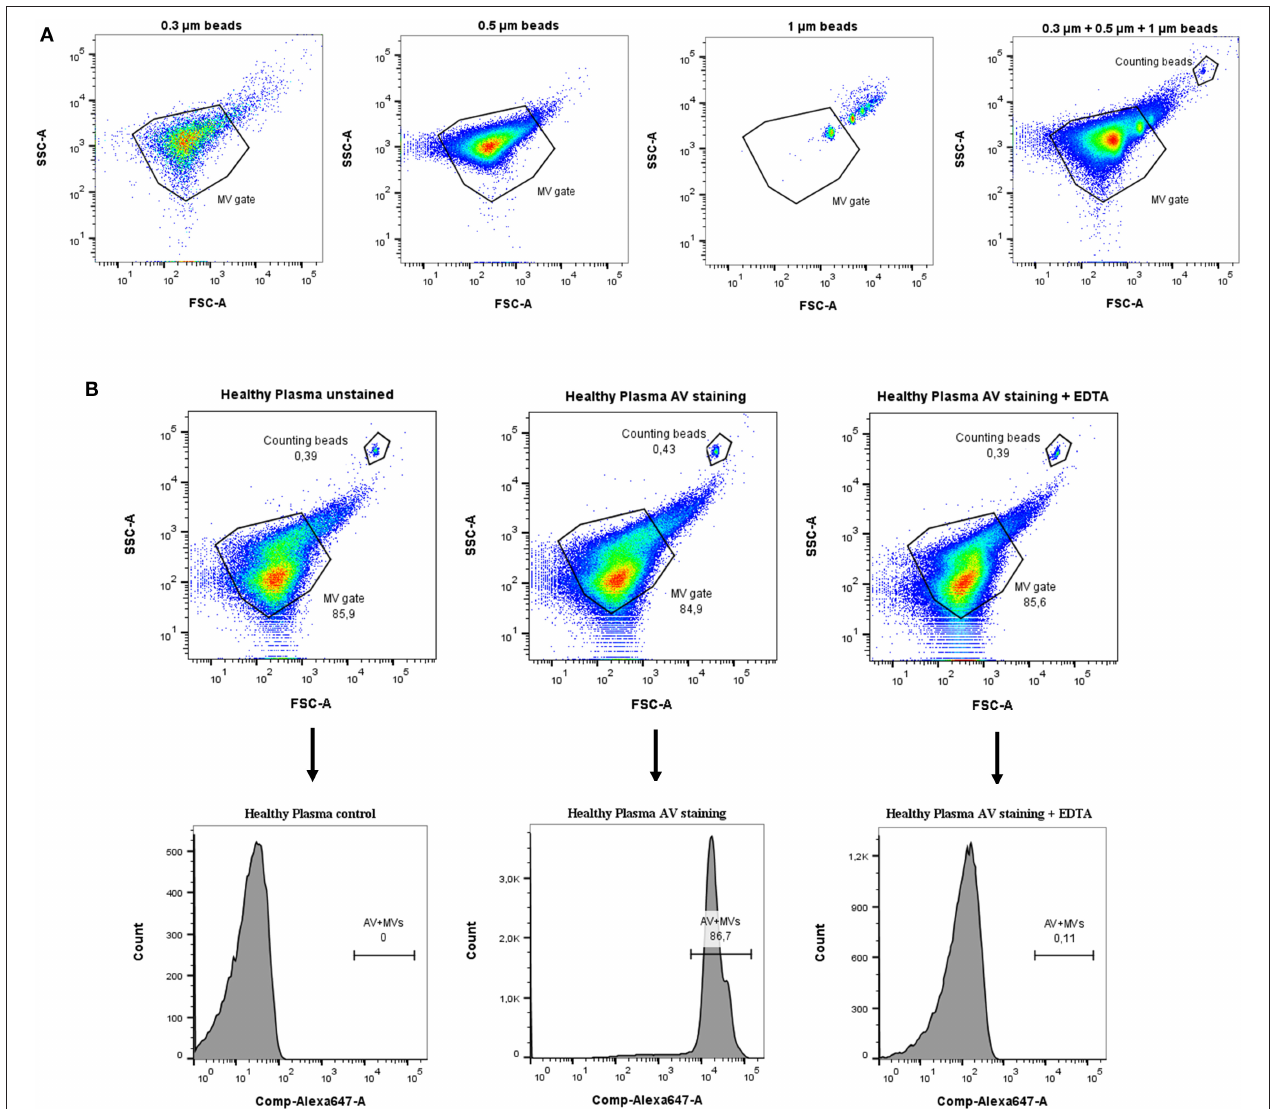
FIGURE 1 | Gating strategy for detection of MVs in plasma samples. (A) Size calibration beads ranging from 0.3 to 1 µ m were used to define a MV gate. (B) AV staining was further included to specifically detect MVs due to their PS surface expression. EDTA control was included to block specific binding of AV to PS. Counting beads were used to quantify the amount of shed MVs in samples as described in the